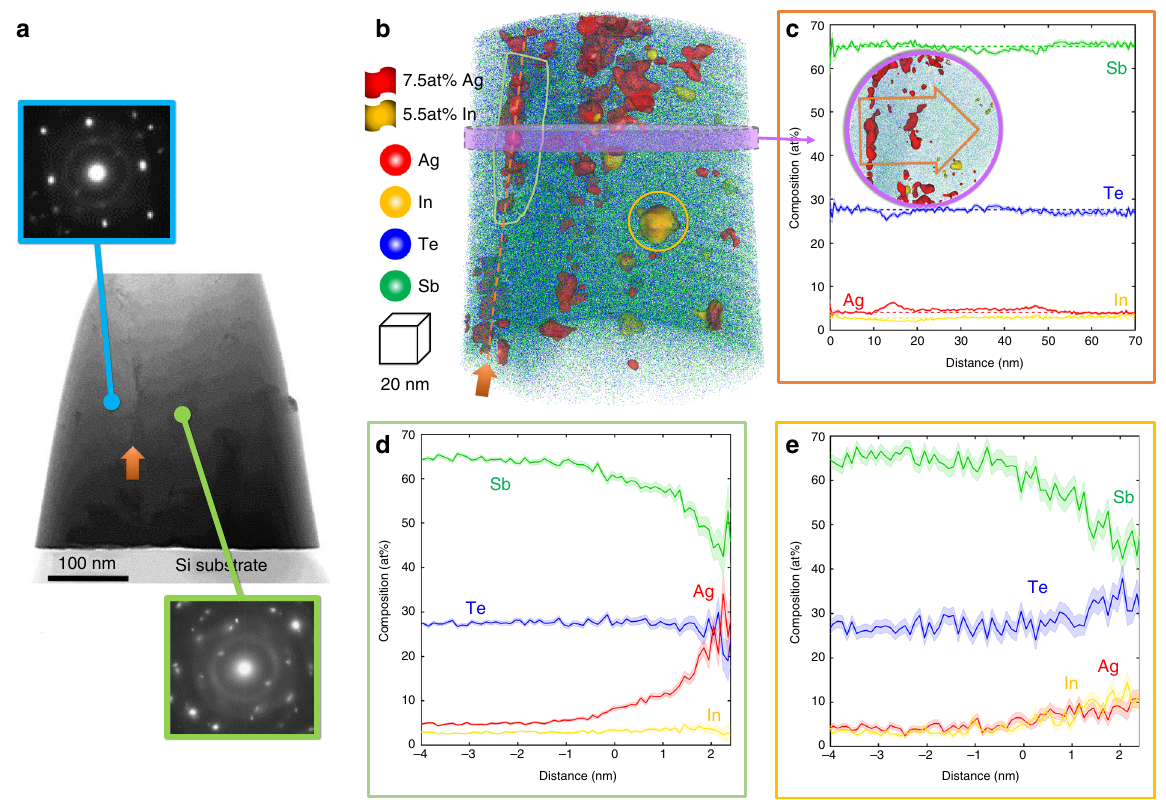
Fig. 3 Correlative APT-TEM investigation of grain boundary in crystalline AIST. a HAADF-STEM image of the needle-shaped AIST specimen along with the diffraction patterns from selected areas evidencing the high-angle grain boundary. b APT mapping of the AIST showing the segregation of Ag. c concentration pro fi les and ion count of the region of interest highlighted by blue cylinder. Proximity histogram concentration pro fi les of Ag, In, Sb, and Te for D: 7.5 at.% Ag and E: 5.5 at.% In iso-concentration surfaces. APT results show that ~3.9 at.% Ag and ~3.3 at.% In substitute the Sb in the quintuple layer, and excessive Ag segregates into the grain boundary